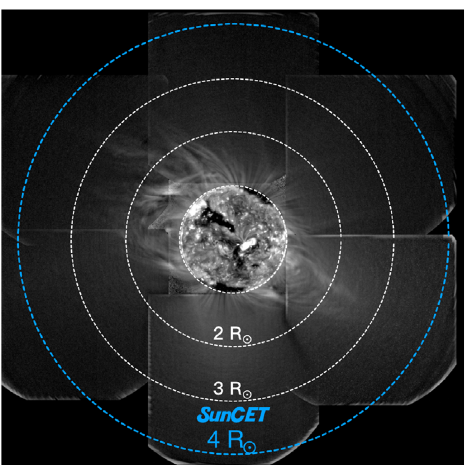
Fig. 10. Composite of GOES/SUVI 195 Å off-point images that shows solar structure out to 3 R (cid:1) – even without a bright CME – before straylight in the instrument becomes comparable with the coronal signal. Adapted from Tadikonda et al.